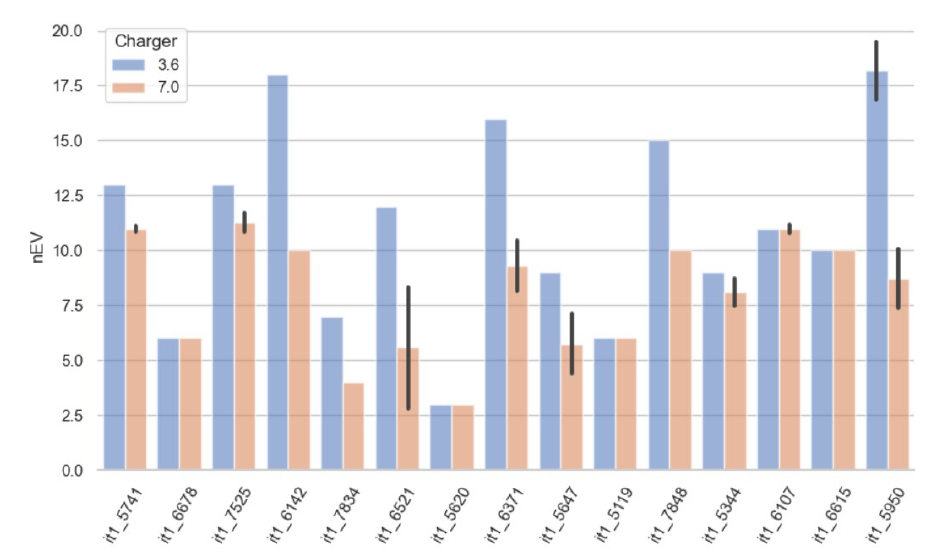
Figure 8. Hosting capacity for 25% of the 75 kVA